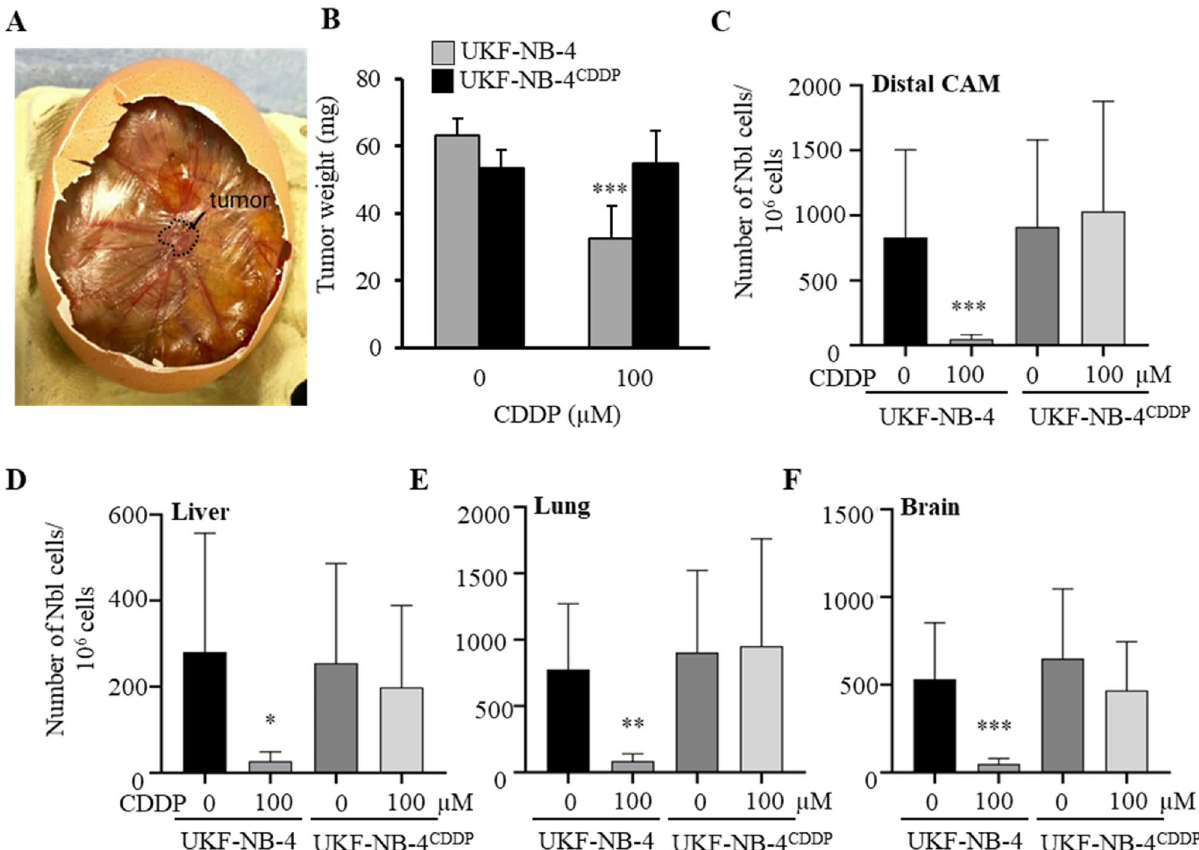
Figure 2. Evaluation of efficiency of CDDP to inhibit tumour growth and metastatic spread of UKF-NB-4 and UKF-NB-4 CDDP cells in CAM assay. ( A ) Representative CAM with the tumor formed 7 th day after induction. ( B ) Weights of tumors excised from the CAM upon experiment termination (17 th day). Numbers of Nbl cells identified in ( C ) distal CAM (extravasation), ( D ) liver, ( E ) lung and ( F ) brain (intravasation). Quantitation of Nbl cells was based on qPCR using Alu primers. In addition, qPCR of chicken GAPDH was performed as an internal control to confirm the presence of equivalent quantities of host genomic DNA. Data shows average ± SEM from three ( n = 3) independent experiments. * p < 0.05; ** p < 0.005, *** p <